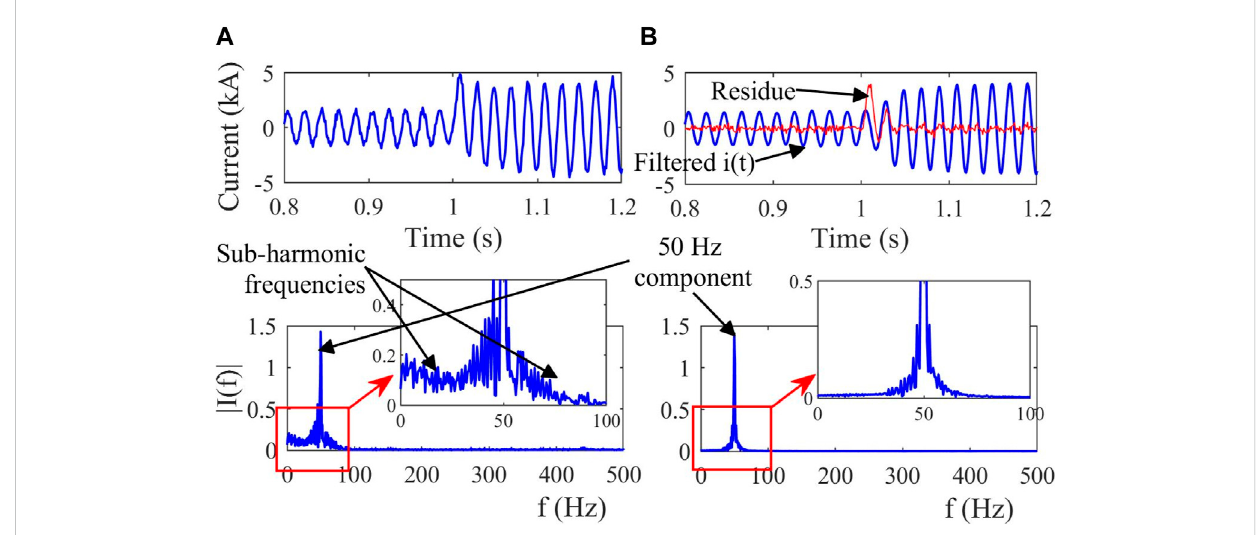
FIGURE 5 Demonstration of the elimination of subharmonic components from the contaminated fault current signal using the Weiner fi lter.